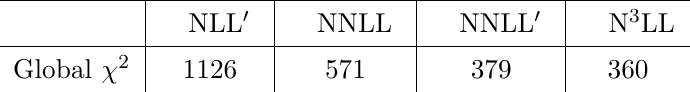
Table 6 . Values of the global (cid:31) 2 of the (cid:12)ts at NLL 0 , NNLL, NNLL 0 , and N 3 LL accuracy.